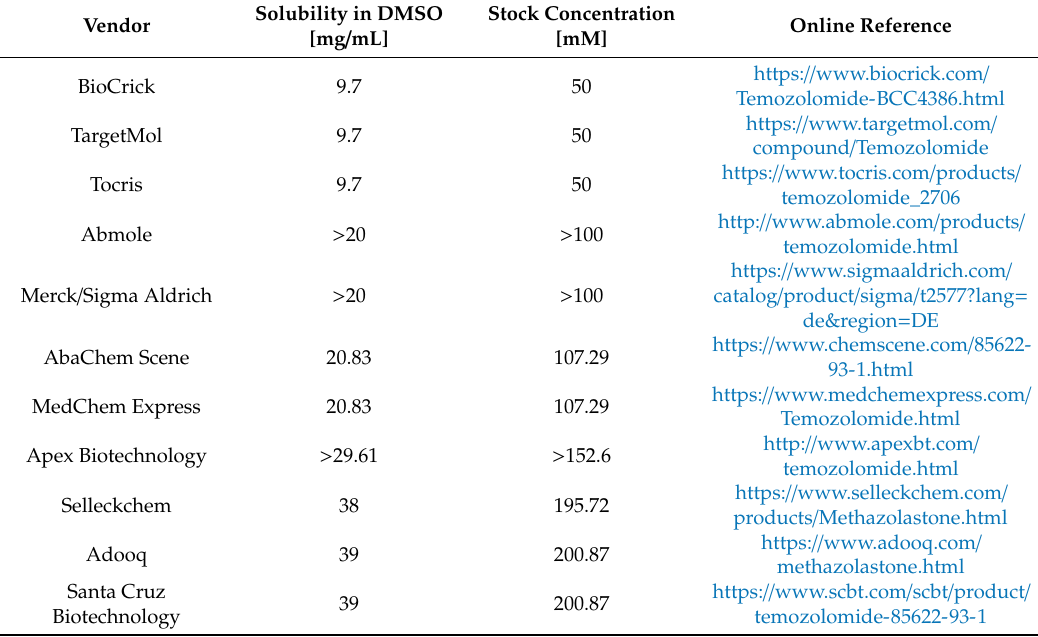
Table 1. Solubility of Temozolomide in dimethyl sulfoxide (DMSO). Online references were accessed on 24 July